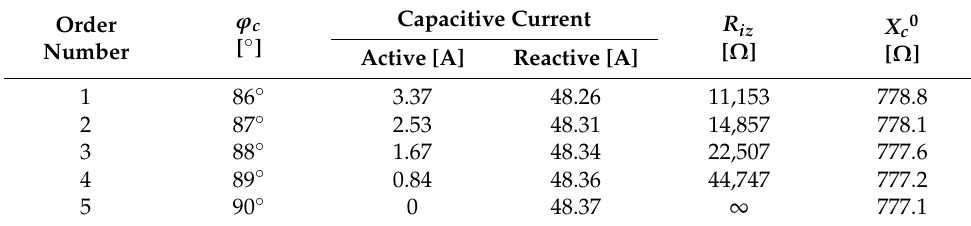
Table 3. The values of the insulation parameters of the electrical network 20 kV.